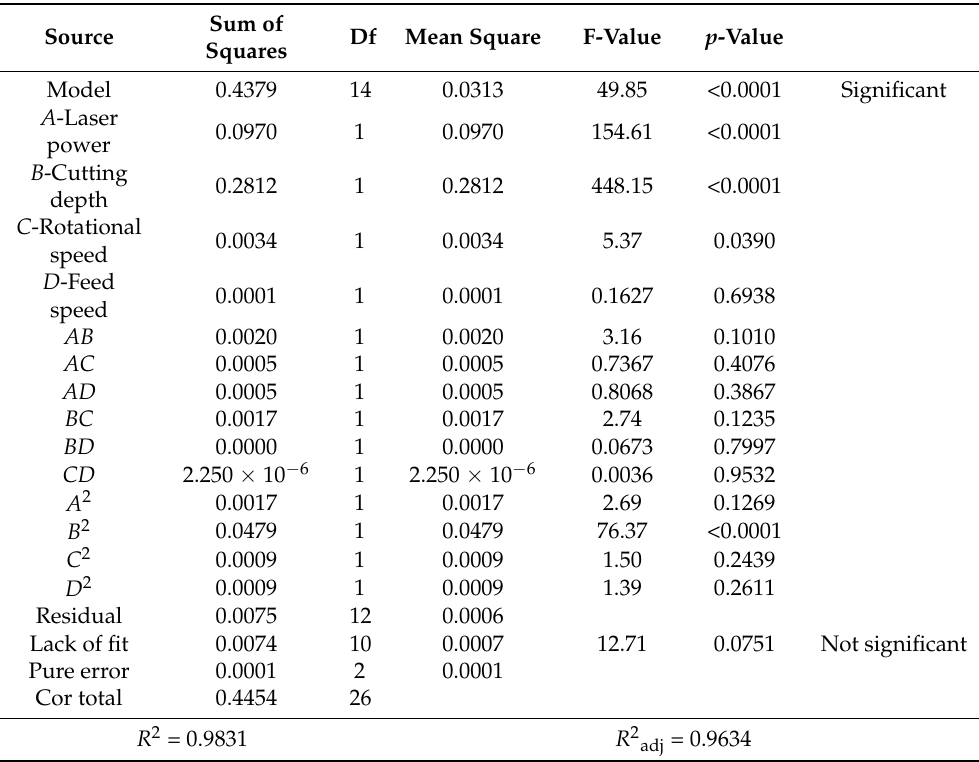
Table 8. Analysis of variance of the regression